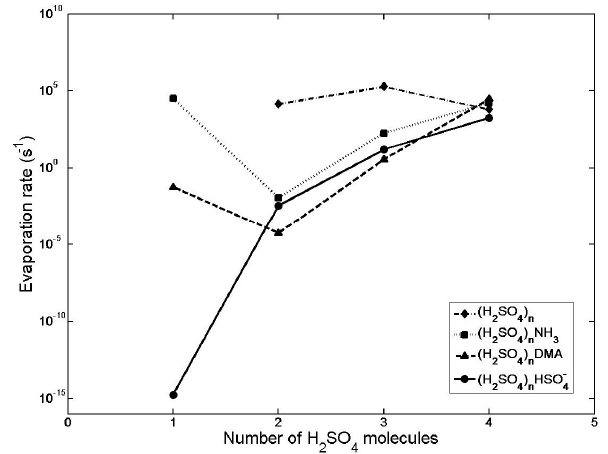
Figure 3. Total evaporation rates at 298.15K (s − 1 ) of sulfuric acid clusters containing one Lewis base versus the number of sulfuric acid molecules in the cluster (not including the bisulfate ion). The dash-dotted line represents pure neutral sulfuric acid clusters, the dotted line represents neutral sulfuric acid clusters with one ammo- nia molecule, the dashed line represents neutral sulfuric acid clus- ters with one DMA molecule and the solid line represents pure sul- furic acid clusters with one HSO − ion. Note that, unlike in Fig. 2, 4 q q 1 now corresponds to H 2 SO 4 X, 2 corresponds to ( H 2 SO 4 ) 2 X etc., where X = NH 3 , DMA or HSO − . 4